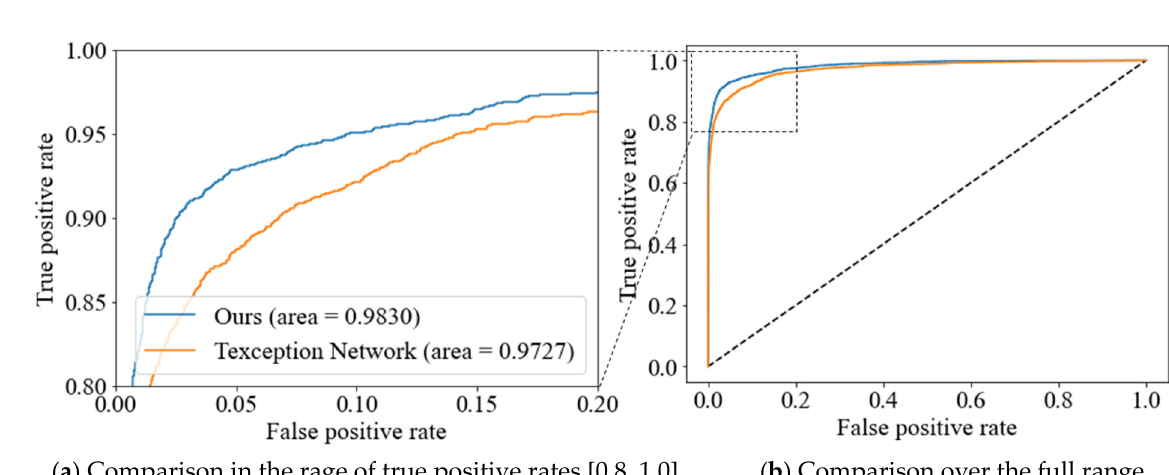
Figure 6. Receiver-operating characteristic (ROC) analysis to show the improvement of recall with the comparative study. ( a ) Comparison of ROC curves in the range of true positive rates [0.8, 1.0]; ( b ) Comparison in [0.0, 1.0] range of ROC curve of Texception Network.